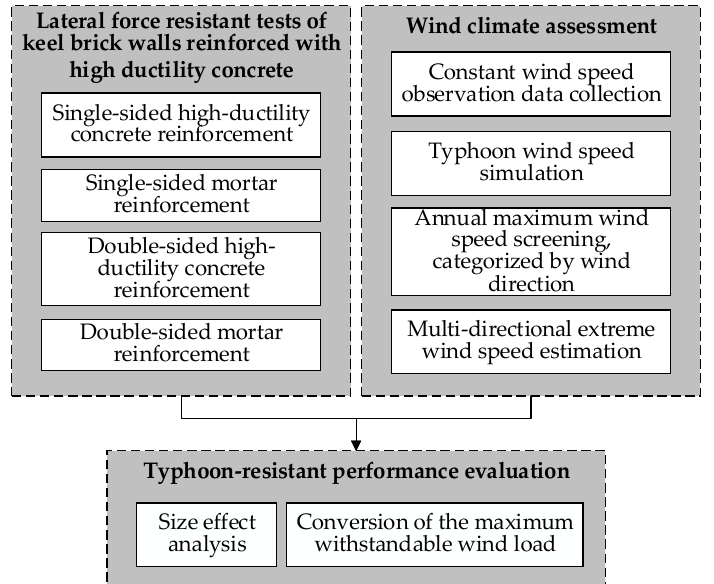
Figure 3. Framework for evaluating the performance of keel brick walls against typhoons.